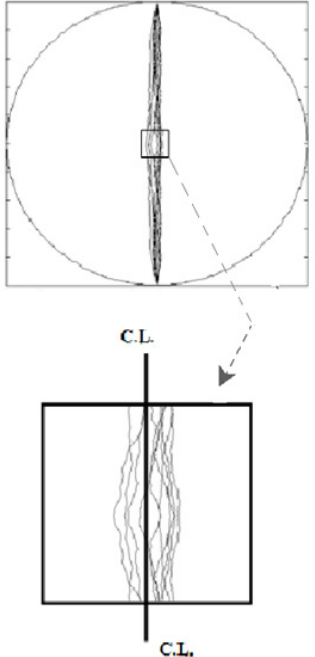
Figure 2: Simulated sandstone crack trajectories with d=1.2 and